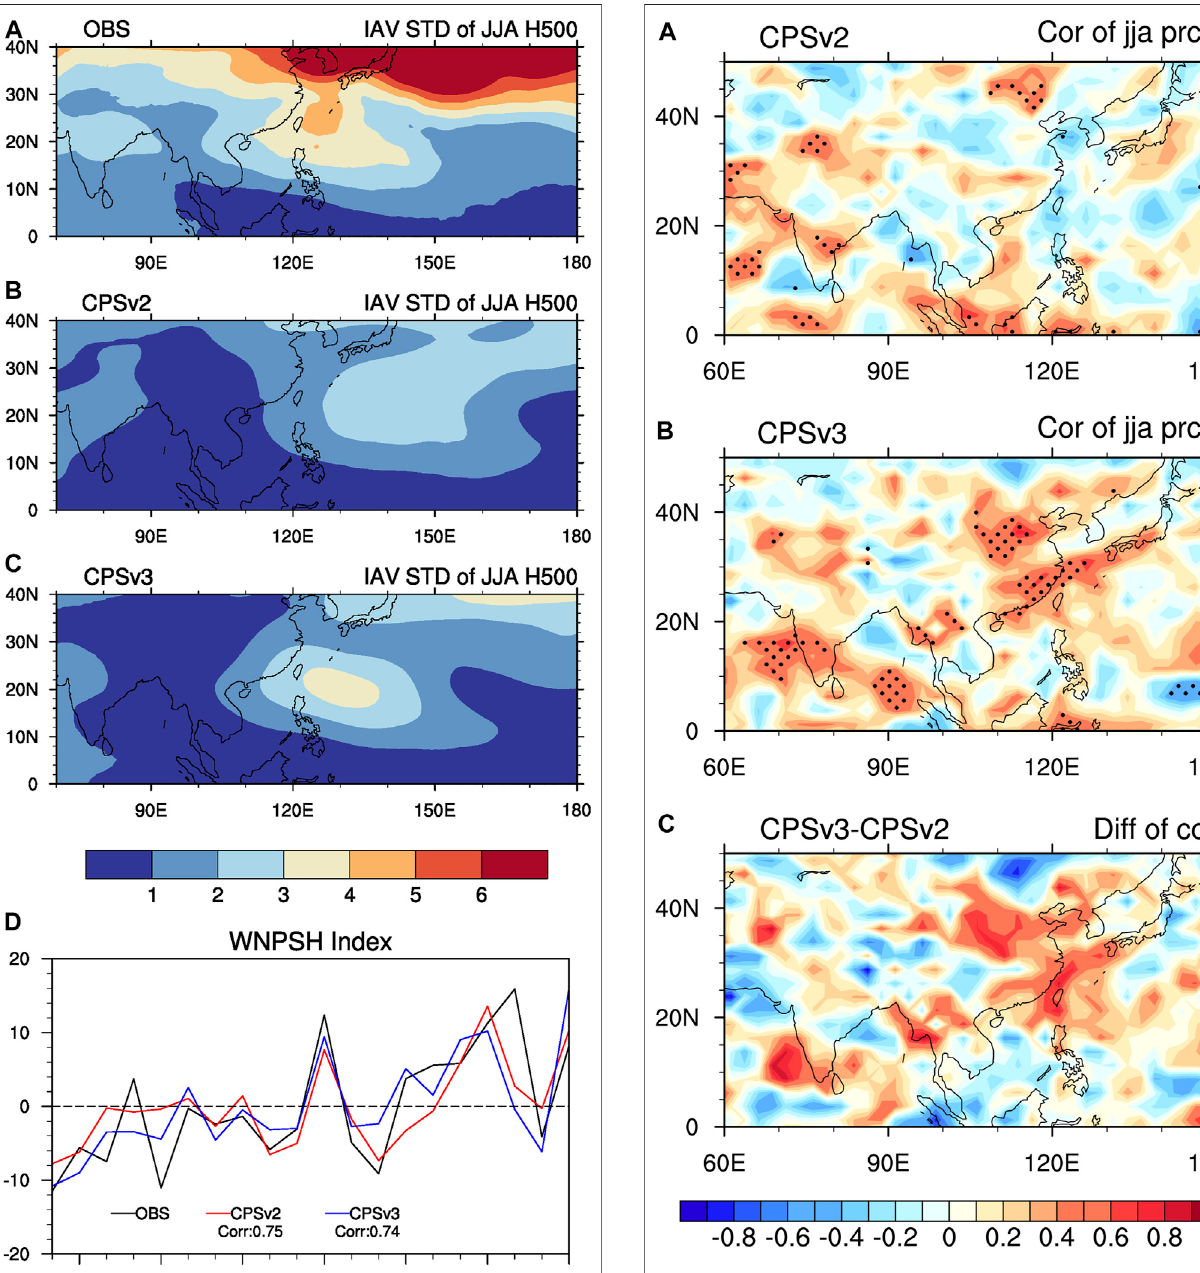
FIGURE 6 | Temporal correlation coef fi cients (TCC) of JJA rainfall between predictions and observations for (A) CPSv2, (B) CPSv3, and (C) difference between (A) and (B) . (locations with correlation values at the 5% signi fi cance level are highlighted by dots)